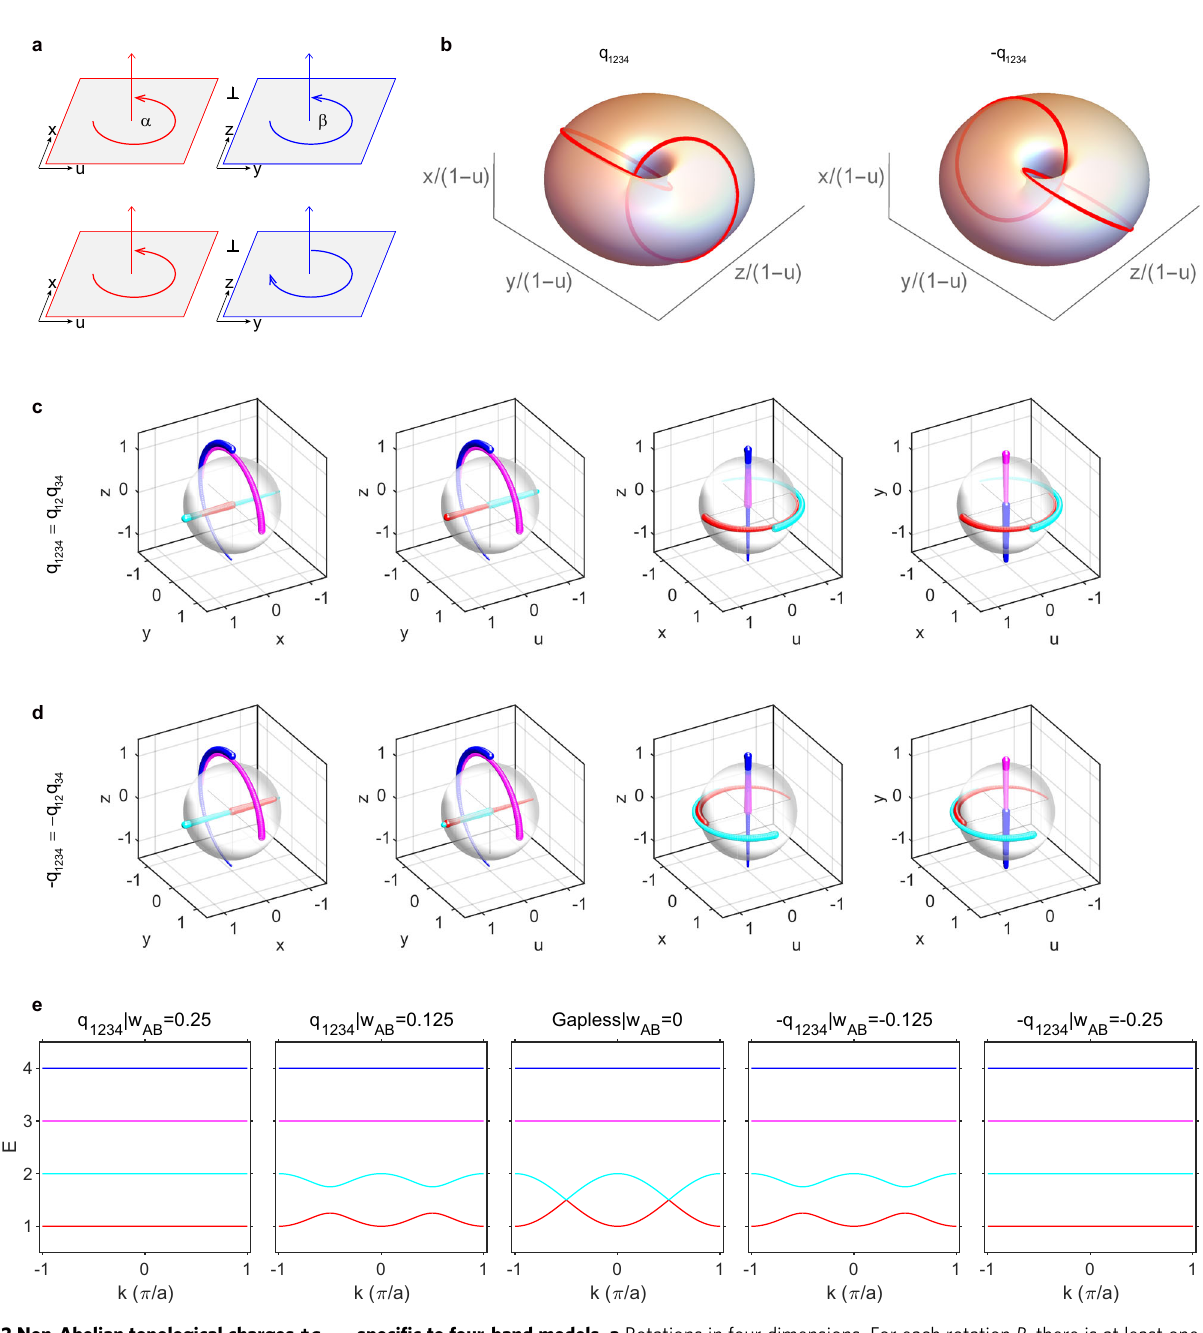
Fig. 2 Non-Abelian topological charges ± q 1234 speci fi c to four-band models. a Rotations in four dimensions. For each rotation R , there is at least one pair of two orthogonal rotation-invariant planes, e.g., A ¼ oux and B ¼ oyz , that span the 4D space. For any ~ a 2 A and ~ b 2 B , we have ~ a ? ~ b , R ~ a 2 A , and R ~ b 2 B . We de fi ne the angle between ~ a and R ~ a ( ~ b and R ~ b ) in the plane A ð B Þ as α ð β Þ . b 4D Clifford tori ð u ; x ; y ; z Þ stereographically projected into R 3 as the (cid:4) (cid:5) ; y ; z conventional tori x . The two linked circles represent the trajectory of one eigenstate (with applying all the 4D D 2 rotations), and the other three 1 (cid:2) u 1 (cid:2) u 1 (cid:2) u eigenstate trajectories overlap with this trajectory (see other cases in Supplementary Fig. 5). c , d Orthographic projections of the four eigenstate trajectories (shown in different colors) onto four 3D solid spheres, where one component is hidden by projection in each sphere. e Topological phase transition between charges ± q 1234 ; other parameters are listed in Supplementary Table α and β correspond to the two rotation angles in the two α ¼ k þ π , where “ ideal ” indicates the fl at-band model given above. 2 orthogonal invariant planes, as shown in Fig. 2a (also see Sup- plementary Note 2: Rotations in four dimensions 23 – 25 ), while η determines the proportions projected onto the two planes. When α ≠ 0 and β ¼ 0 (or α ¼ 0 and β ≠ 0), the rotations are called single rotations. For example, all ideal rotations R ð k Þ with k ¼ (cid:2) π ! π enabling charge q belong to the case with the settings η ¼ π and 12 2